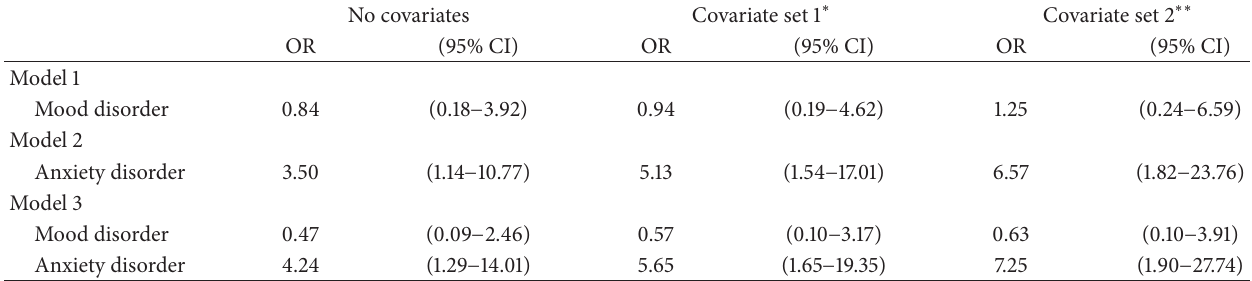
Table 2: Association between baseline psychiatric status and incident hypertension at 1